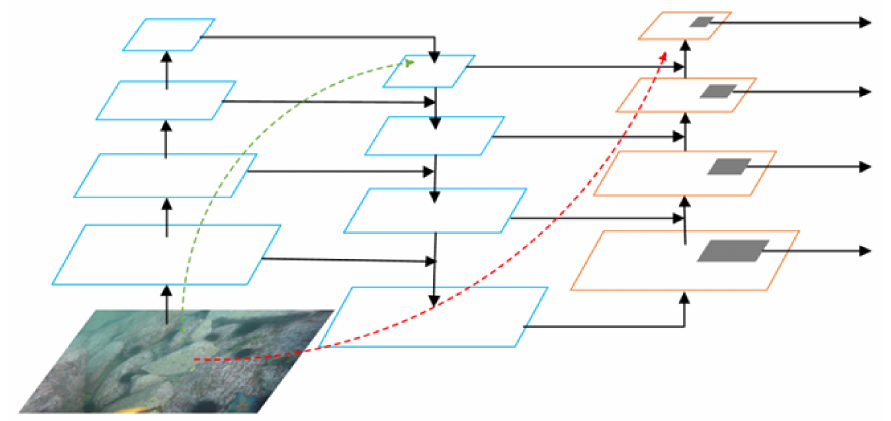
Figure 5. Residual feature extraction network with a combination of top-down and bottom-up